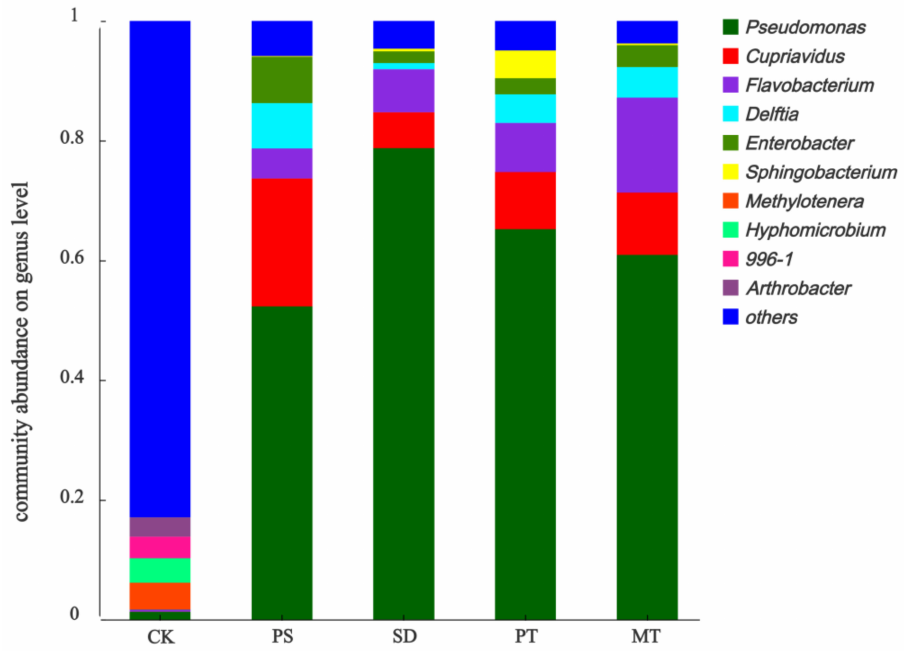
Figure 11. Community structure of bacteria, at genus level, after treatment with different car- bon